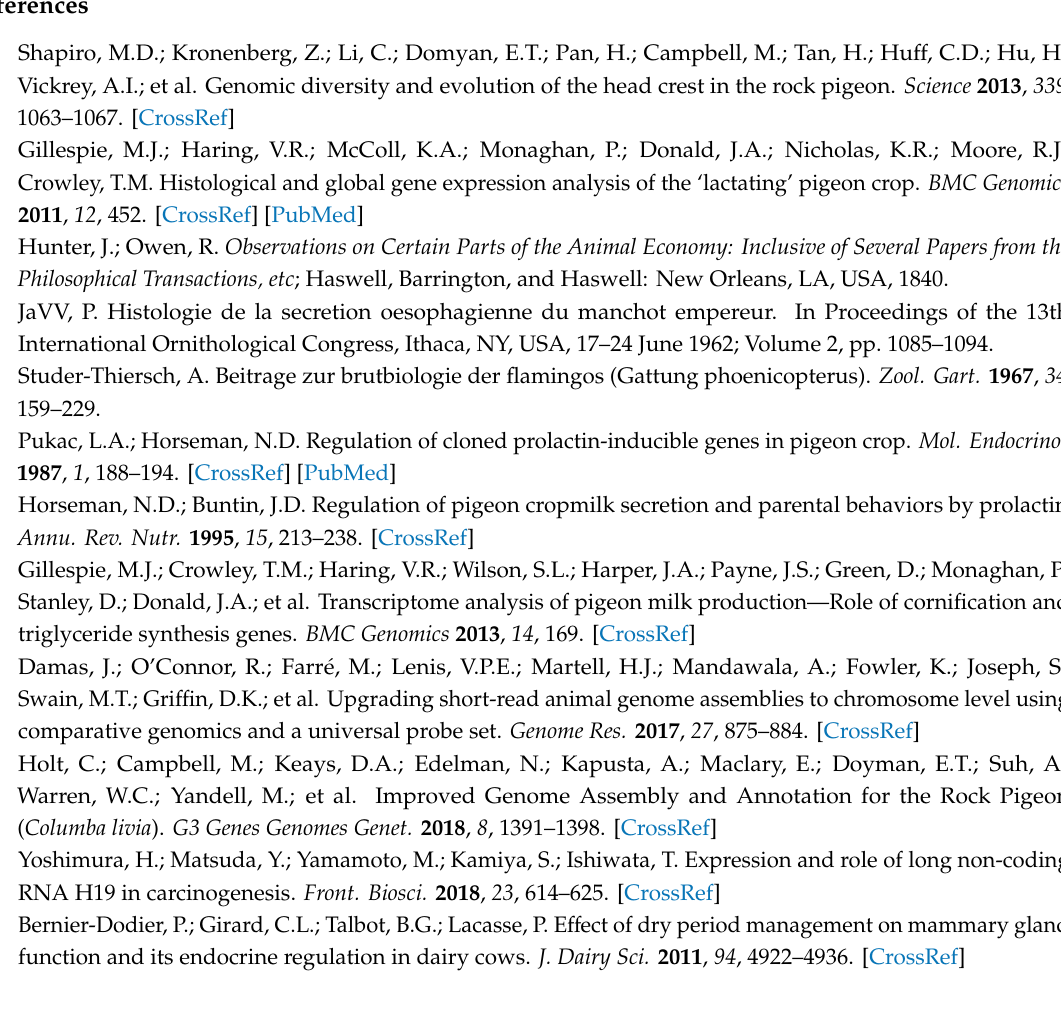
Figure S1: Venn graph showing number of identified lncRNAs from an intersection of CNCI, CPC, PFAM and CPAT results, Table S1: Primers of lncRNAs and mRNAs used in qRT-PCR, Table S2: Known lncRNAs identified in pigeon lactating and non-lactating crops, Table S3: Novel lncRNAs identified in pigeon ‘lactating’ and non-lactating crops, Table S4: Di ff erentially expressed mRNAs identified in pigeon ‘lactating’ and non- ‘lactating’ crops, Table S5: Di ff erentially expressed known lncRNAs identified in pigeon ‘lactating’ and non- ‘lactating’ crops, Table S6: Di ff erentially expressed novel lncRNAs identified in pigeon ‘lactating’ and non-‘lactating’ crops, Table S7: Di ff erentially expressed lncRNAs-gene pairs between ‘lactating’ and non-‘lactating’ crops of pigeons, Table S8: Significant terms in biological process of GO analysis, Table S9: Significant terms in cellular components of GO analysis, Table S10: Significant terms in molecular function of GO analysis. Table S11. KEGG pathway enrichment analysis of di ff erentially expressed